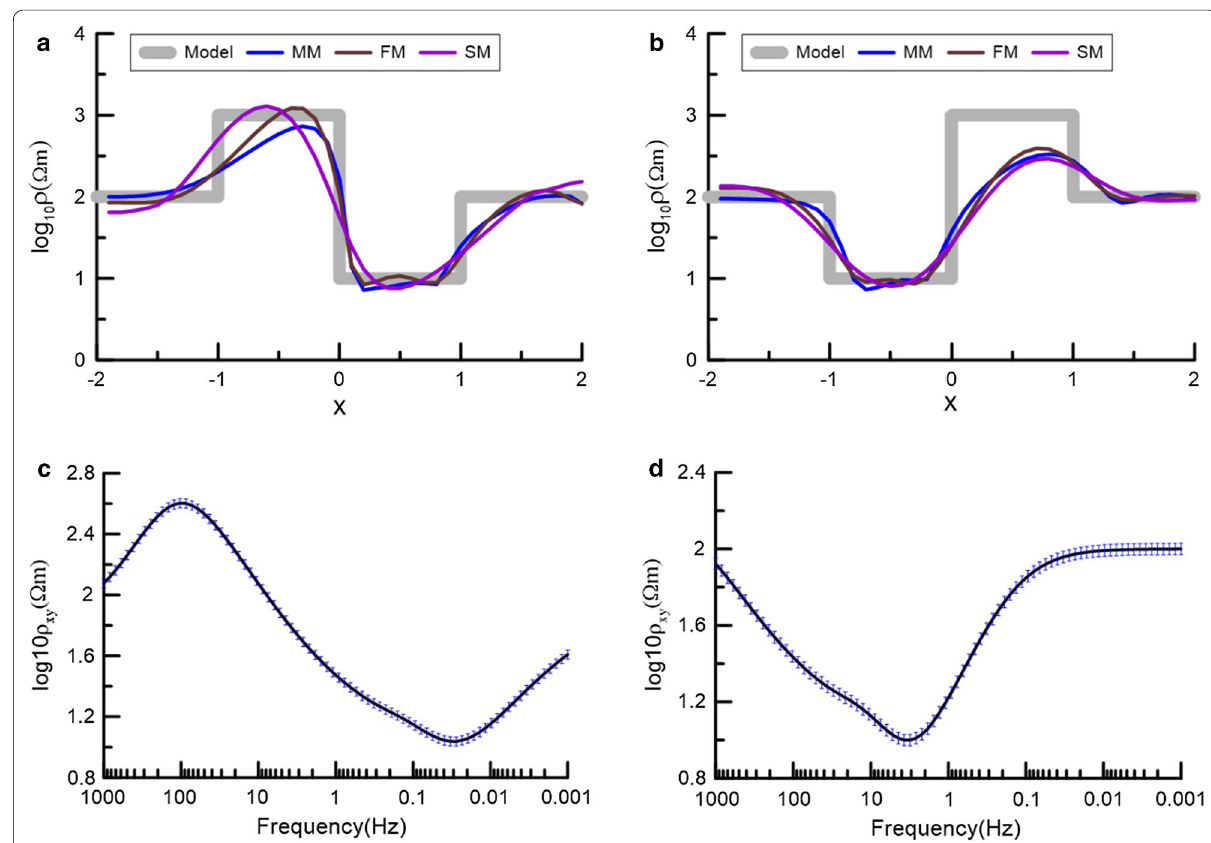
Fig. 2 1D-layered model inversion results of a model A, b model B, c synthetic sounding curve of the model A, and d synthetic sounding curve of model B. x in horizontal axis is the logarithm of the depth, and the unit of depth is km. Thick gray line indicates a profile of the synthetic model, and thin lines with different colors correspond to different stabilizing functionals as shown in the legend on the